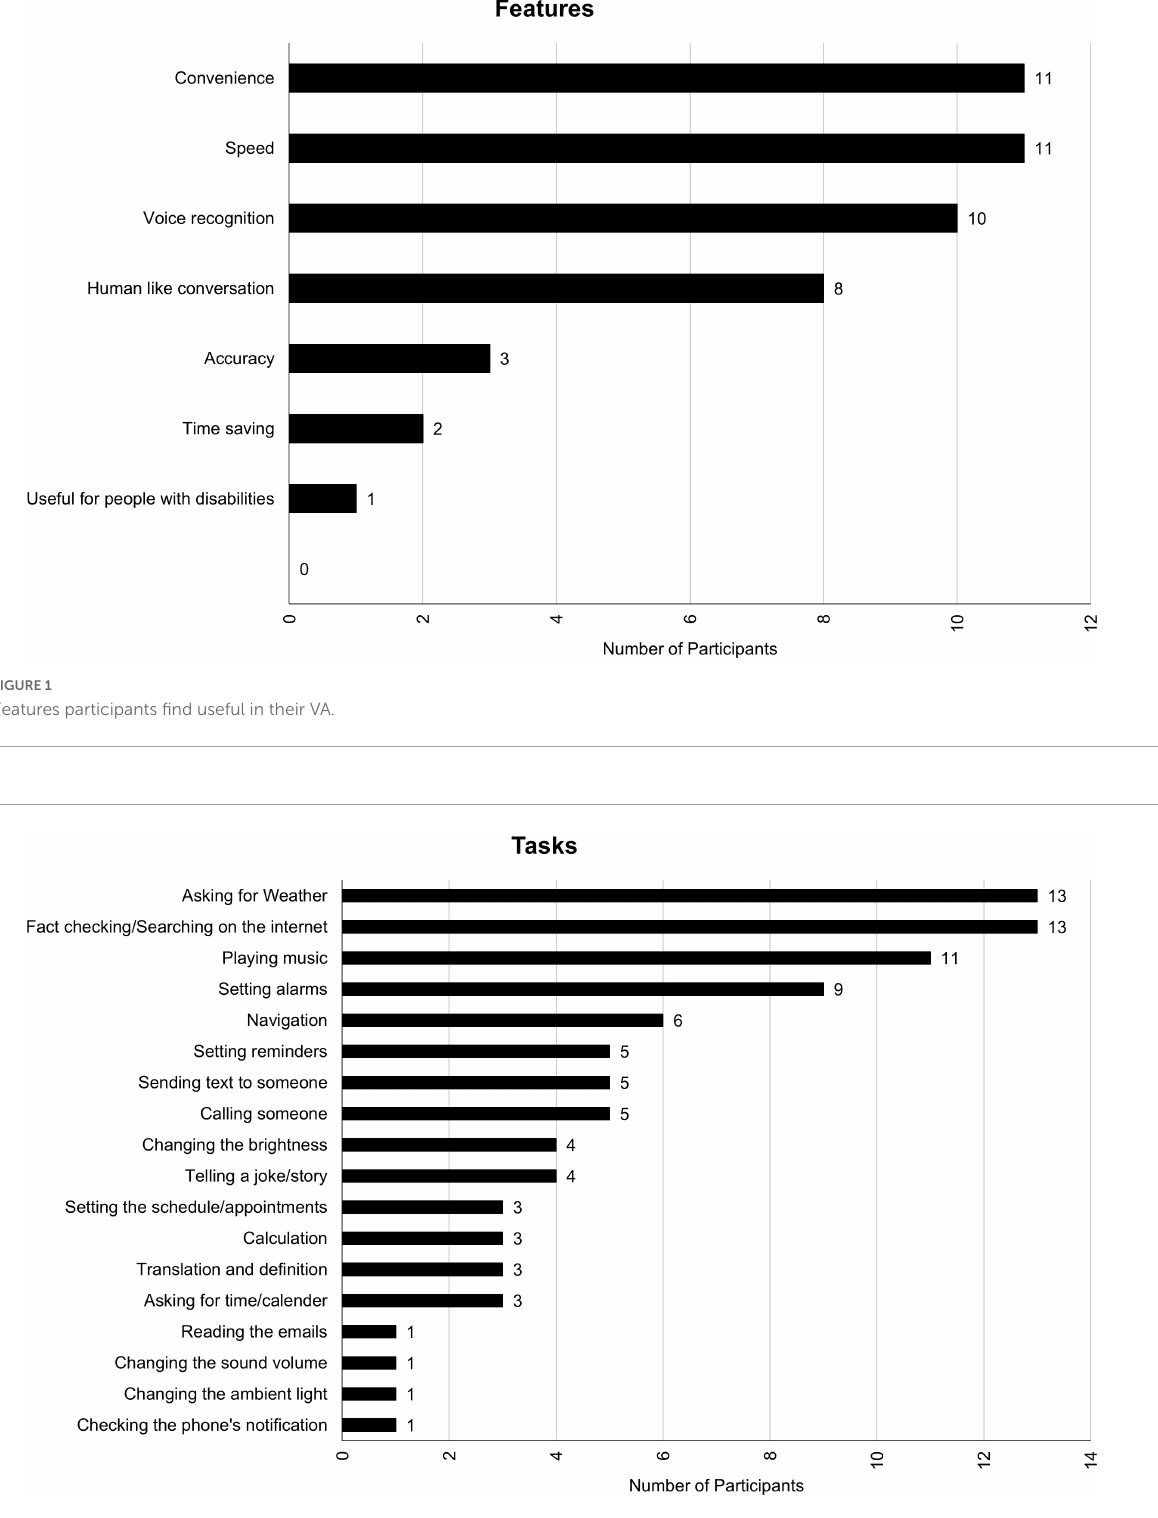
FIGURE2 Tasks participants assign to their